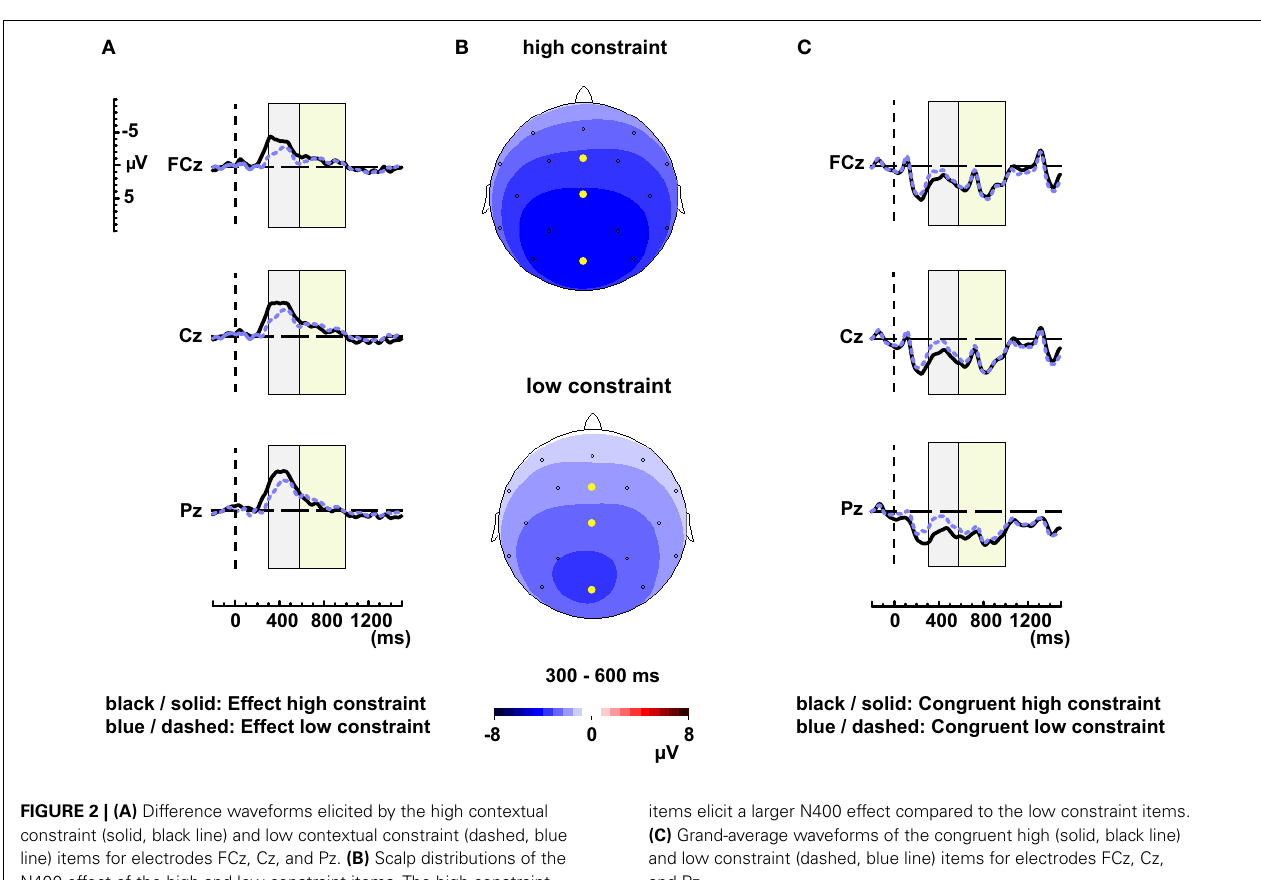
FIGURE 2 | (A) Difference waveforms elicited by the high contextual constraint (solid, black line) and low contextual constraint (dashed, blue line) items for electrodes FCz, Cz, and Pz. (B) Scalp distributions of the N400 effect of the high and low constraint items.The high constraint